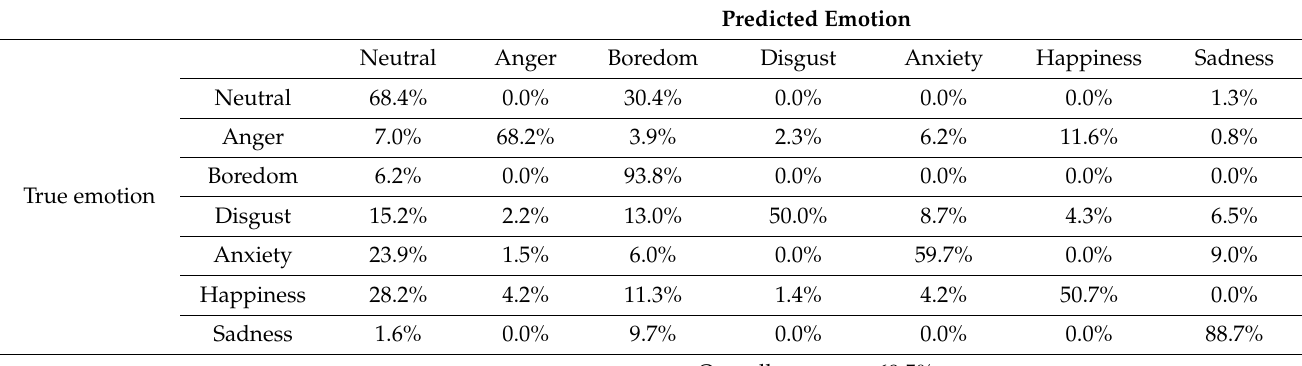
Table 15. Confusion matrix of the emotion classification results of the proposed cascaded DnCNN–CNN that was trained on the German EMO-DB mixed with the TMETRO